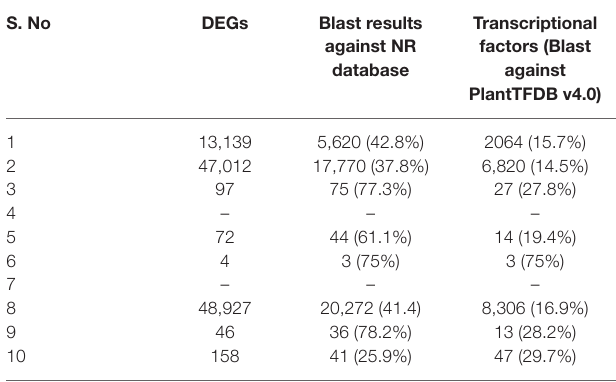
A total of 43,861 transcripts had hits with other known proteins in the databases.